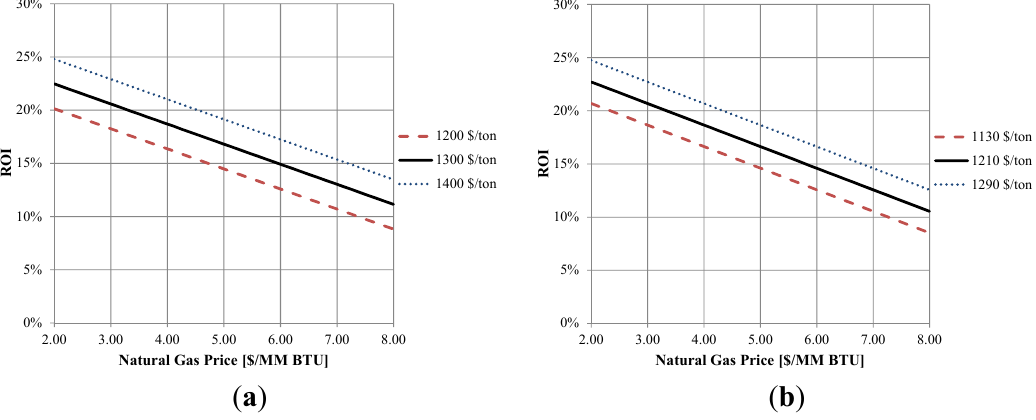
Figure 7. Sensitivity analysis for the ROI of MTO ( a ) and MTP ( b ) when natural gas is the feedstock for product selling prices over a range of natural gas purchased